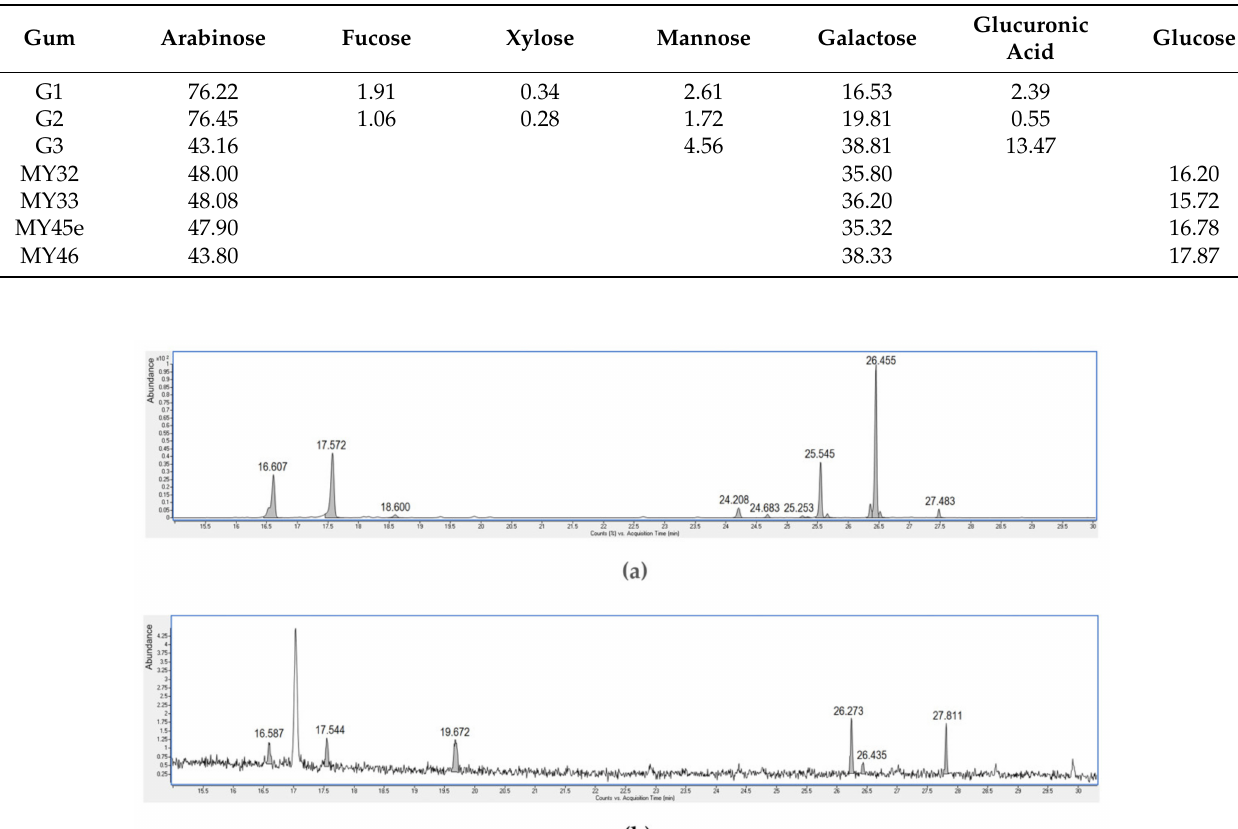
Table 2: in the acacia gums (G1 and G2) arabinose, galactose, mannose, fucose, xylose and glucuronic acid were detected. Conversely, in the chromatogram of Neem gum (Figure 5a) arabinose, galactose, mannose and glucuronic acid were revealed, whereas peaks related to fucose and xylose are missing. Table 2. Polysaccharide percentage content of reference gums and paint samples.